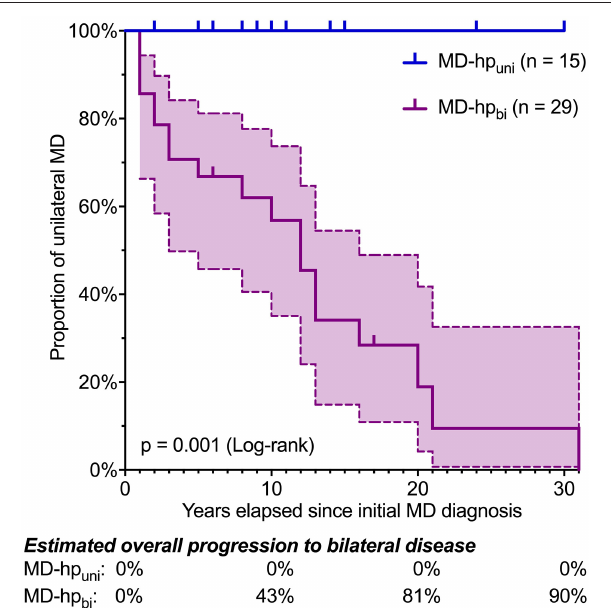
FIGURE 2 | Kaplan–Meier plot for progression to bilateral MD in the MD-hp uni and MD-hp bi cohorts. Ticks indicate censored cases. In the MD-hp bi cohort, median time to bilateral progression was 12 years. None of the MD-hp uni patients developed bilateral disease within 30 years. Dashed lines indicate 95% confidence intervals.